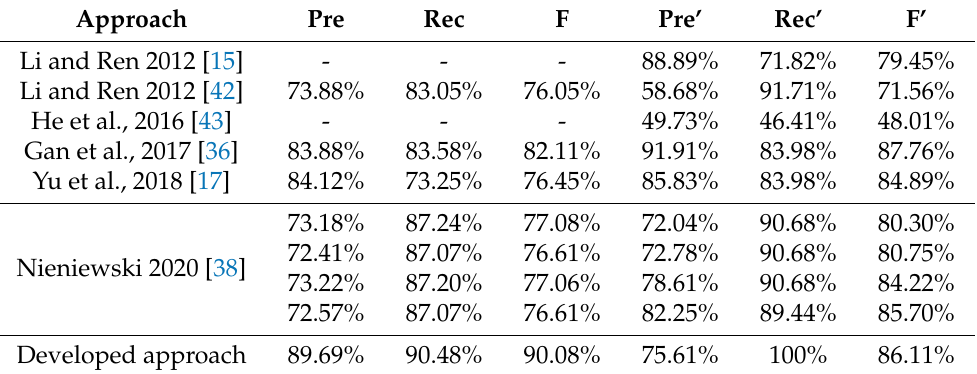
Table 8. Comparison with the literature (Type-II